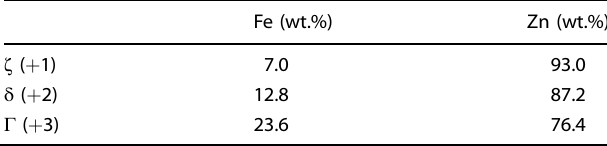
Table 3. EDS quantitative analysis at each point marked on Fig.